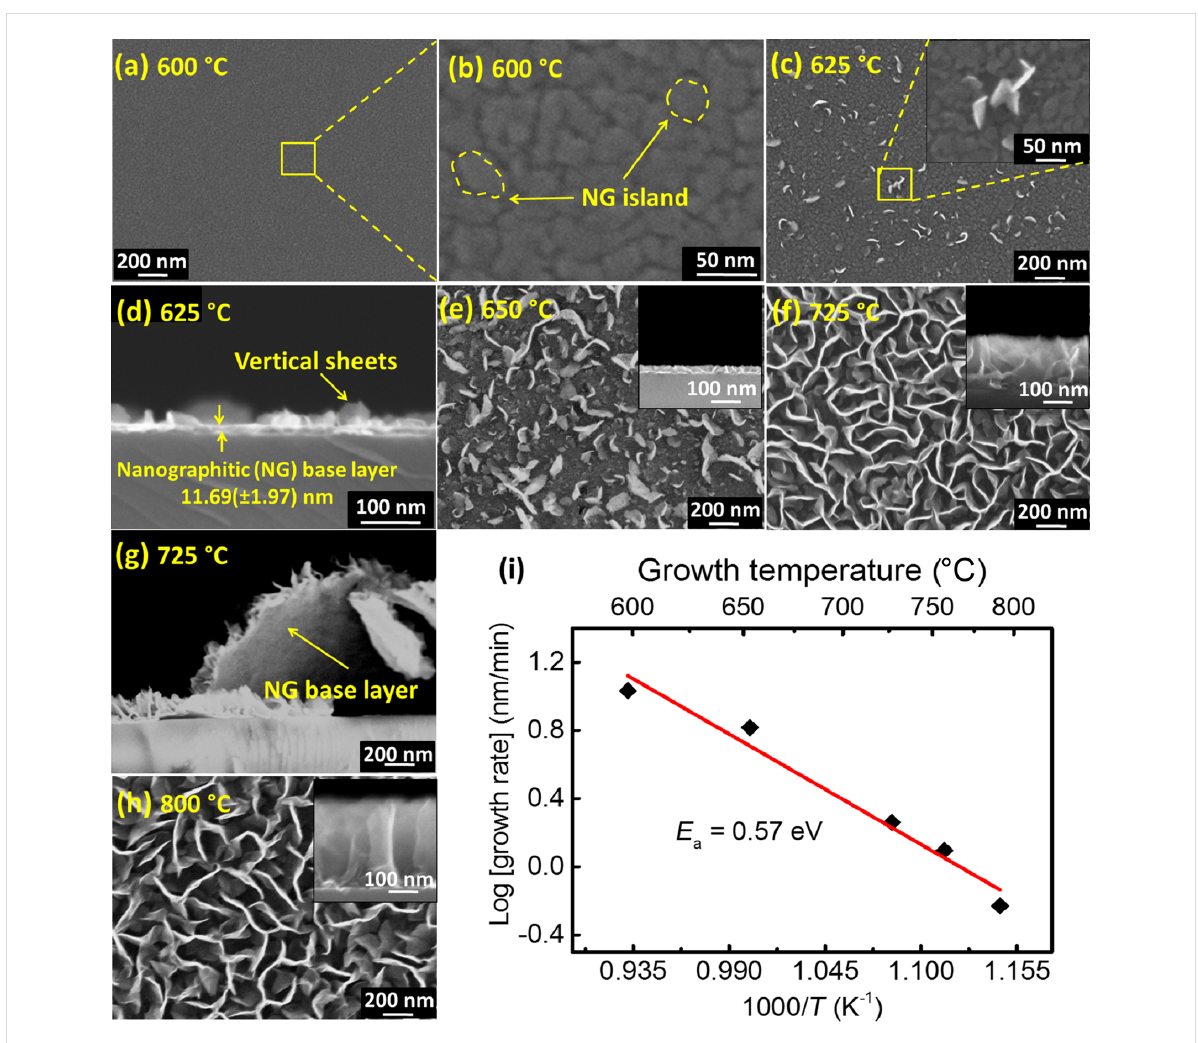
Figure 1: Scanning electron micrographs of the samples grown at different substrate temperatures (a,b) 600 °C, (c) 625 °C, (d) 625 °C (cross section), (e) 650 °C, (f) 725 °C, (g) 725 °C (cross section) and (h) 800 °C, while deposition time, microwave power and distance from plasma source to substrate were 30 min, 320 W and 30 cm, respectively. (i) Arrhenius plot of the growth rate versus the inverse of the substrate